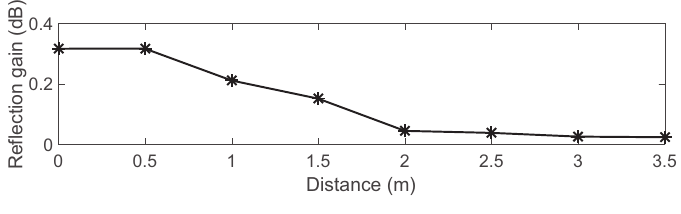
Figure 8. Tag reflection gain.